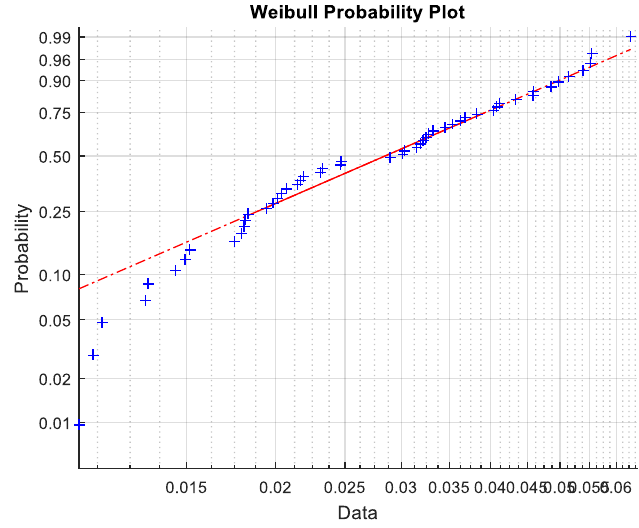
= 1 / Z = 1, ... 52), with Z k (k k